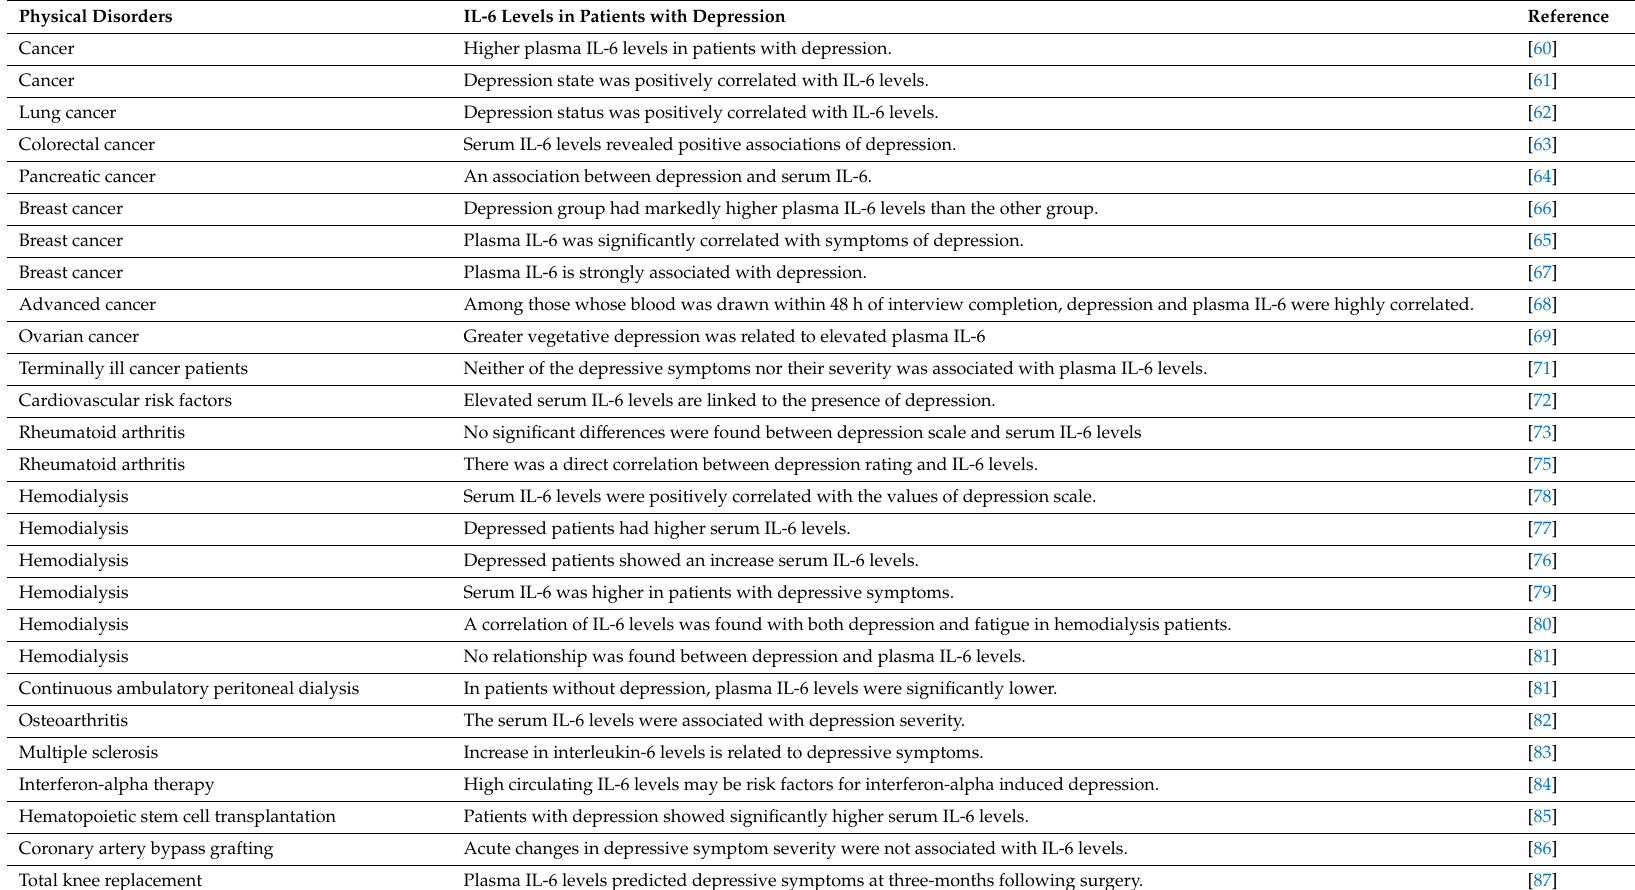
Table 1. Studies of IL-6 levels in physical diseases associated with